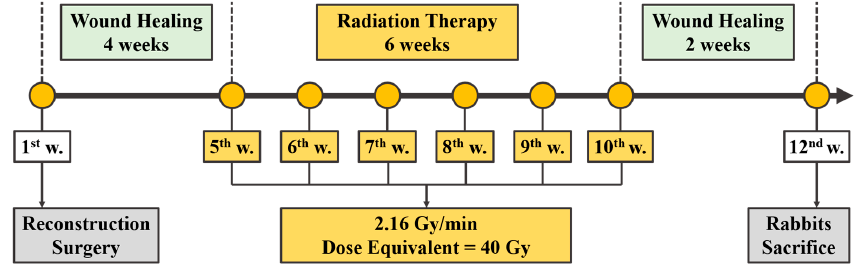
Figure 4. Time course of radiation treatment after reconstruction surgery.